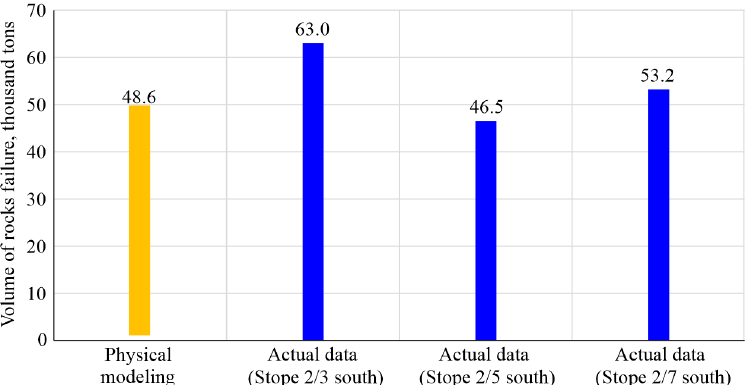
Figure 10. Areas of deformations development in the rocks of the hanging wall and sloping bottom with an increase in the depth of mining.